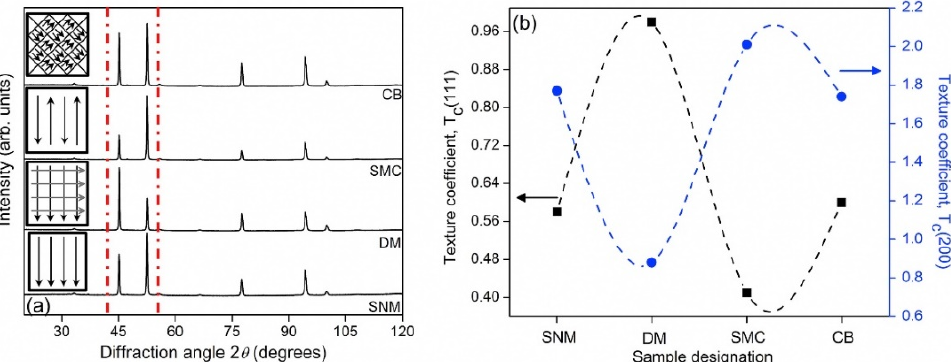
Figure 31. ( a ) XRD patterns (λ = 0.17889 nm) of Al-12Si SLM specimens produced using different hatch styles and ( b ) corresponding texture coefficient of the Al (111) and (200) planes [157]. Copyright 2016. Adapted with permission from Elsevier Science Ltd. under the license number 4803730407471 (Figure 3 [157]), dated 7 April 2020.